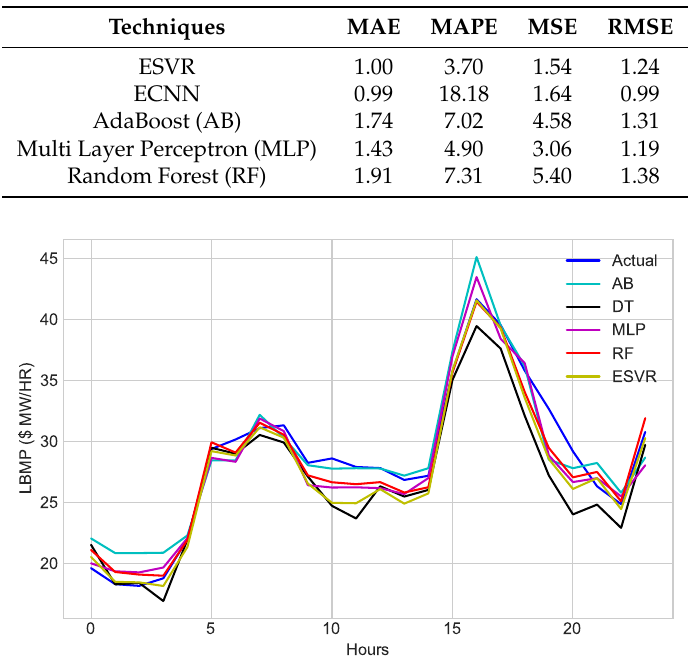
Figure 23. Comparison of proposed models with benchmark schemes.